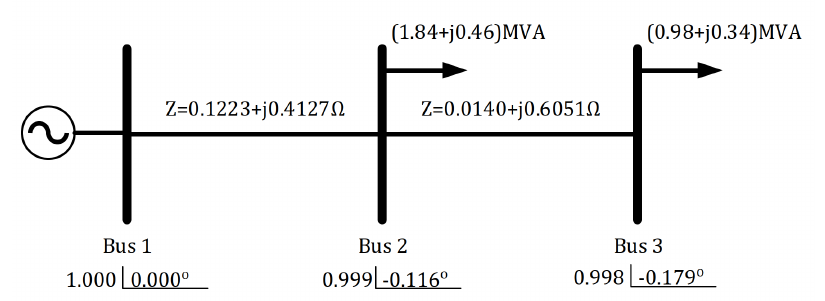
Figure 1. Didactic 3-bus distribution